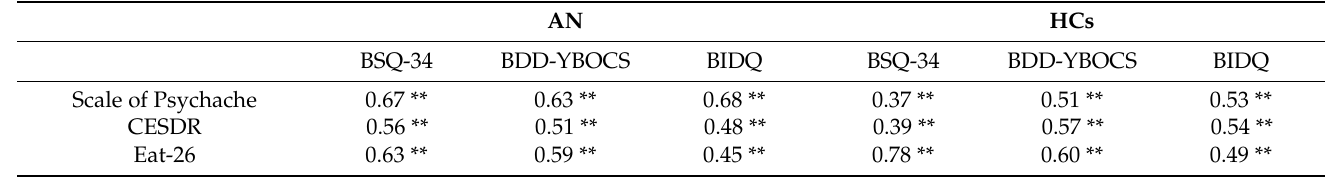
Table 2. Correlations between indicators of BID and clinical traits in the AN and the HCs group.